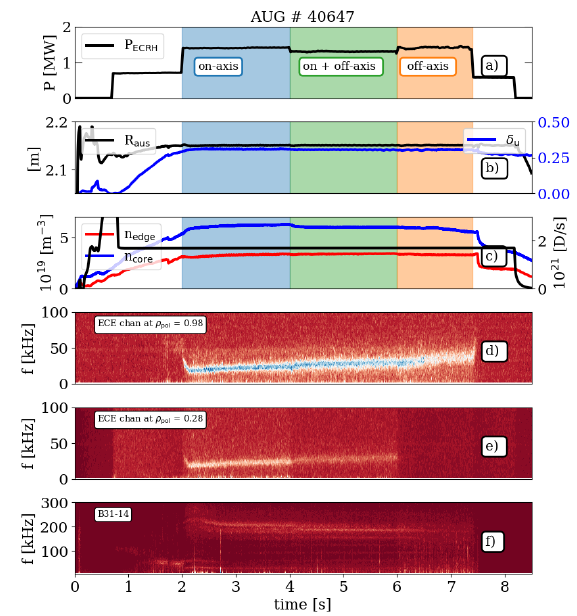
Figure 6. AUG #40647: Temporal evolution of plasma param- eters during EDA H-mode. a) ECRH heating scheme. b) Outer plasma boundary R aus (black) and upper triangularity δ u (blue). c) edge and core densities together with the deuterium fuelling. d) Spectrogram of the edge ECE channel. e) Spectrogram of the ECE core channel. f) Spectrogram of the magnetic coil